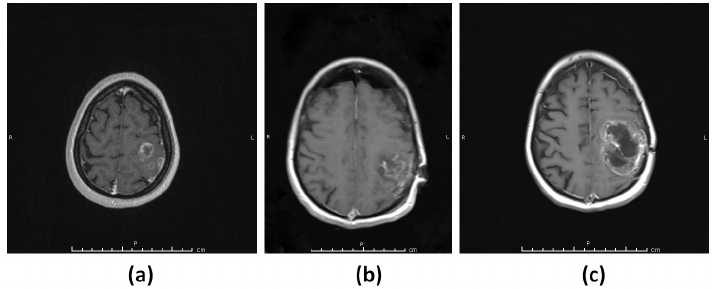
Figure 2. Patient 2 (G2). ( a ) T 1 -weighted MRI showing a contrast-enhancing lesion in the left frontoparietal lobe. ( b ) T 1 -weighted MRI showing gross total resection of the tumor. ( c ) T 1 -weighted MRI showing rapid recurrence of the tumor.